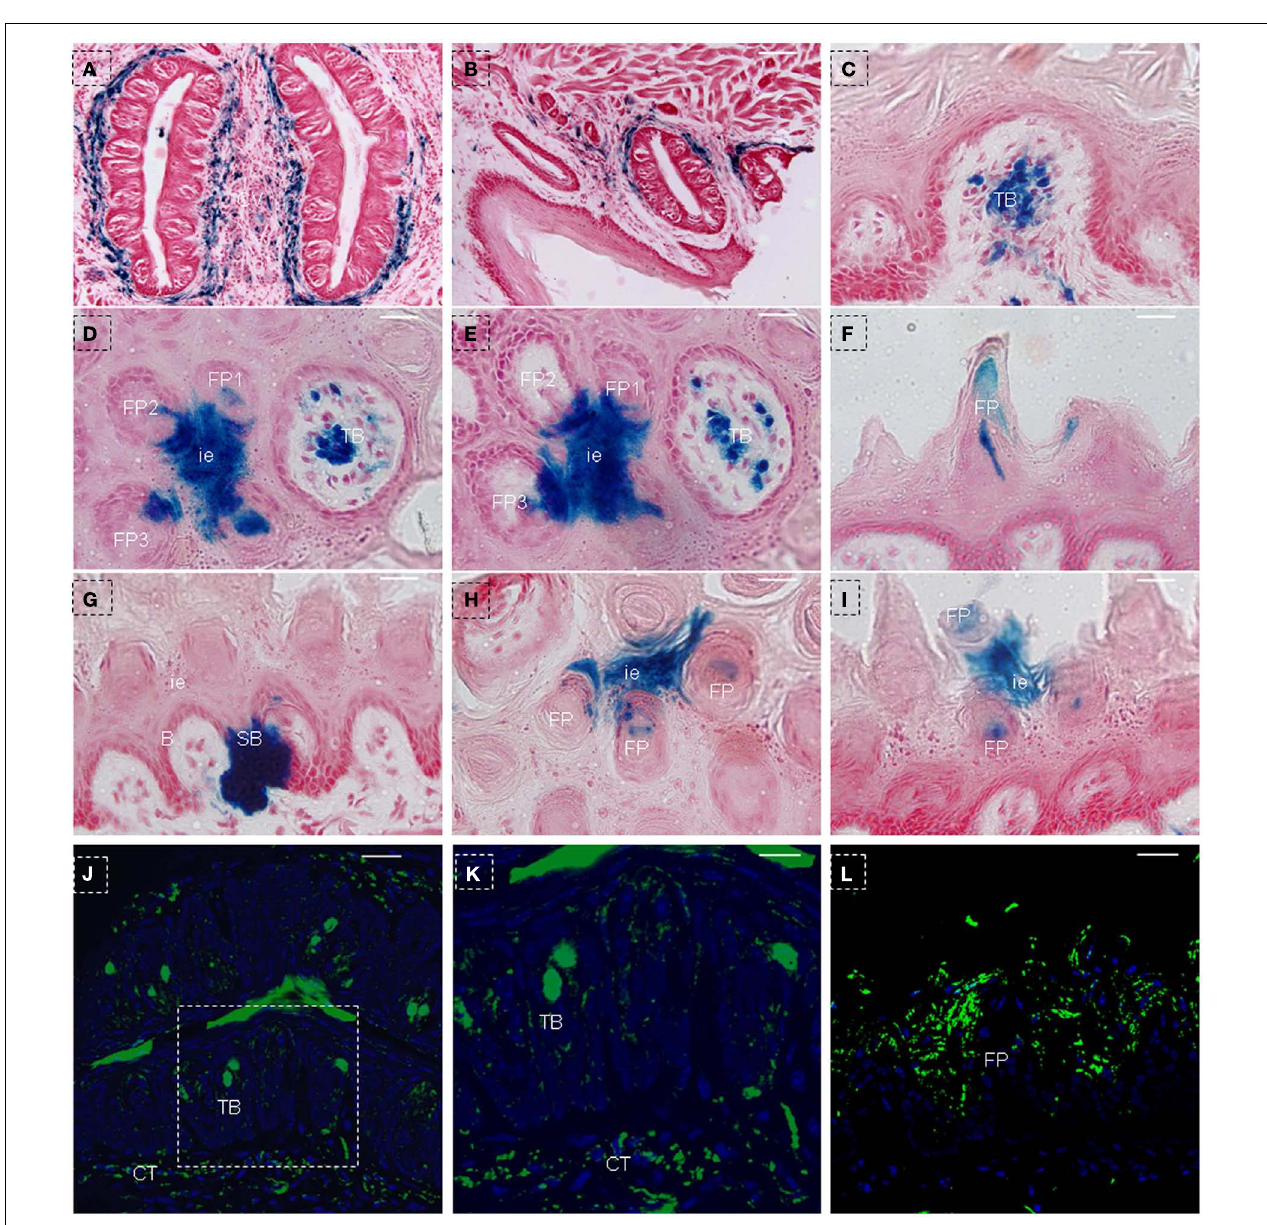
epithelium and spine of filiform papillae (H) . In frontal sections, LacZ staining was found in the spine of filiform papillae and interpapillary epithelium (I) . Immunostaining with anti- β -Gal revealed positive cells in taste buds and connective tissue around the CV papillae (J) . (K) High magnification of taste bud from the dotted frame in (J) . Immunostaining with anti- β -Gal revealed positive cells in the lingual epithelia and filiform papillae (L) . B, basal cell layer; SB, suprabasal cell layer; CT, connective tissue; CV, circumvallate papillae; FP, filiform papillae; FuP, fungiform papillae; ie, interpapillary epithelia;TB, taste bud. Scale bar: (A,B) , 125 µ m: (C–I) , 12 µ m; (J,L) , 50 µ m; (K) , 20 µ